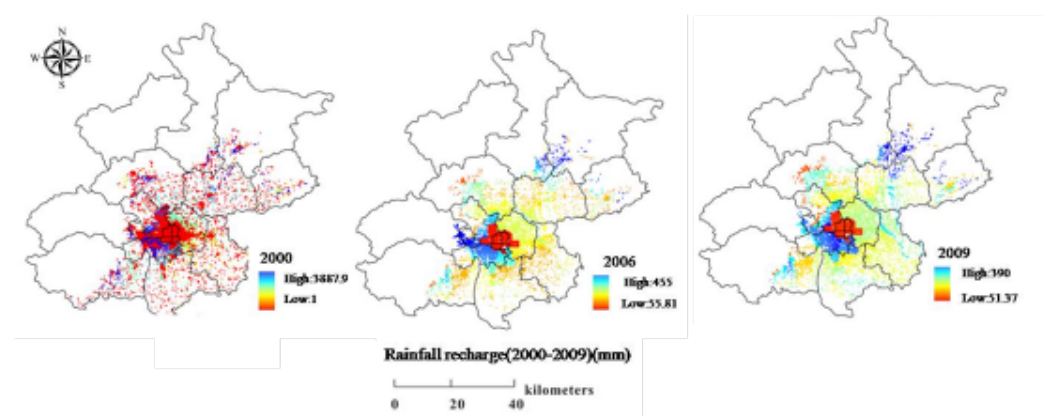
Figure 2. Spatial and temporal variability of rainfall (1997–2011).